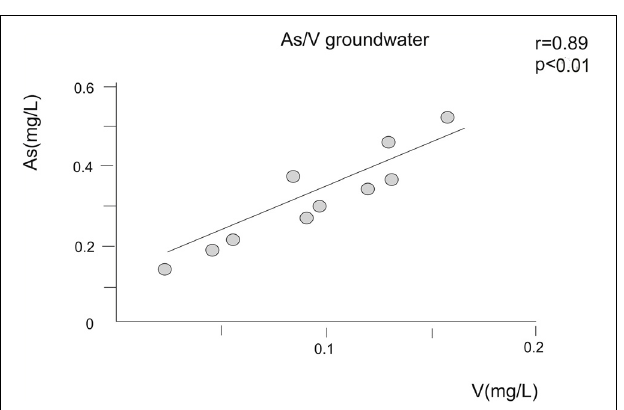
FIGURE 4 | Correlations between As and V in groundwater.